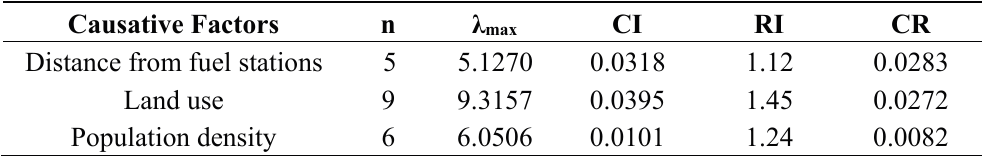
Table 5. Number of order of matrix n, largest eigen value λ max of the preference matrix, consistency index (CI), random consistency index (RI), and consistency ratio (CR), for the fire potential causative factors.